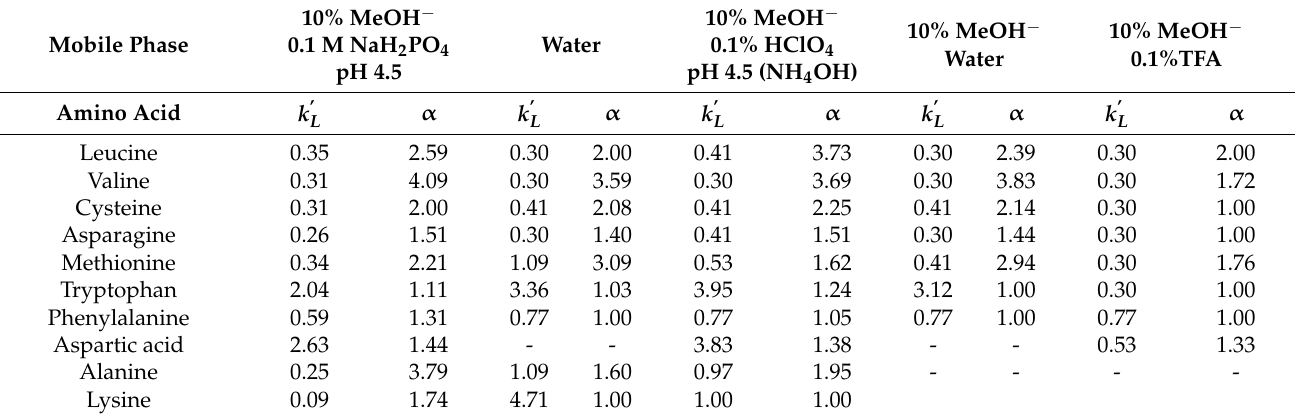
Table 3. Enantioselectivity and resolution for amino acids obtained with Chloro-E-CSP depending on the composition of the mobile phase (0.7 mL/min flow rate, 25 ◦ C, t 0 =